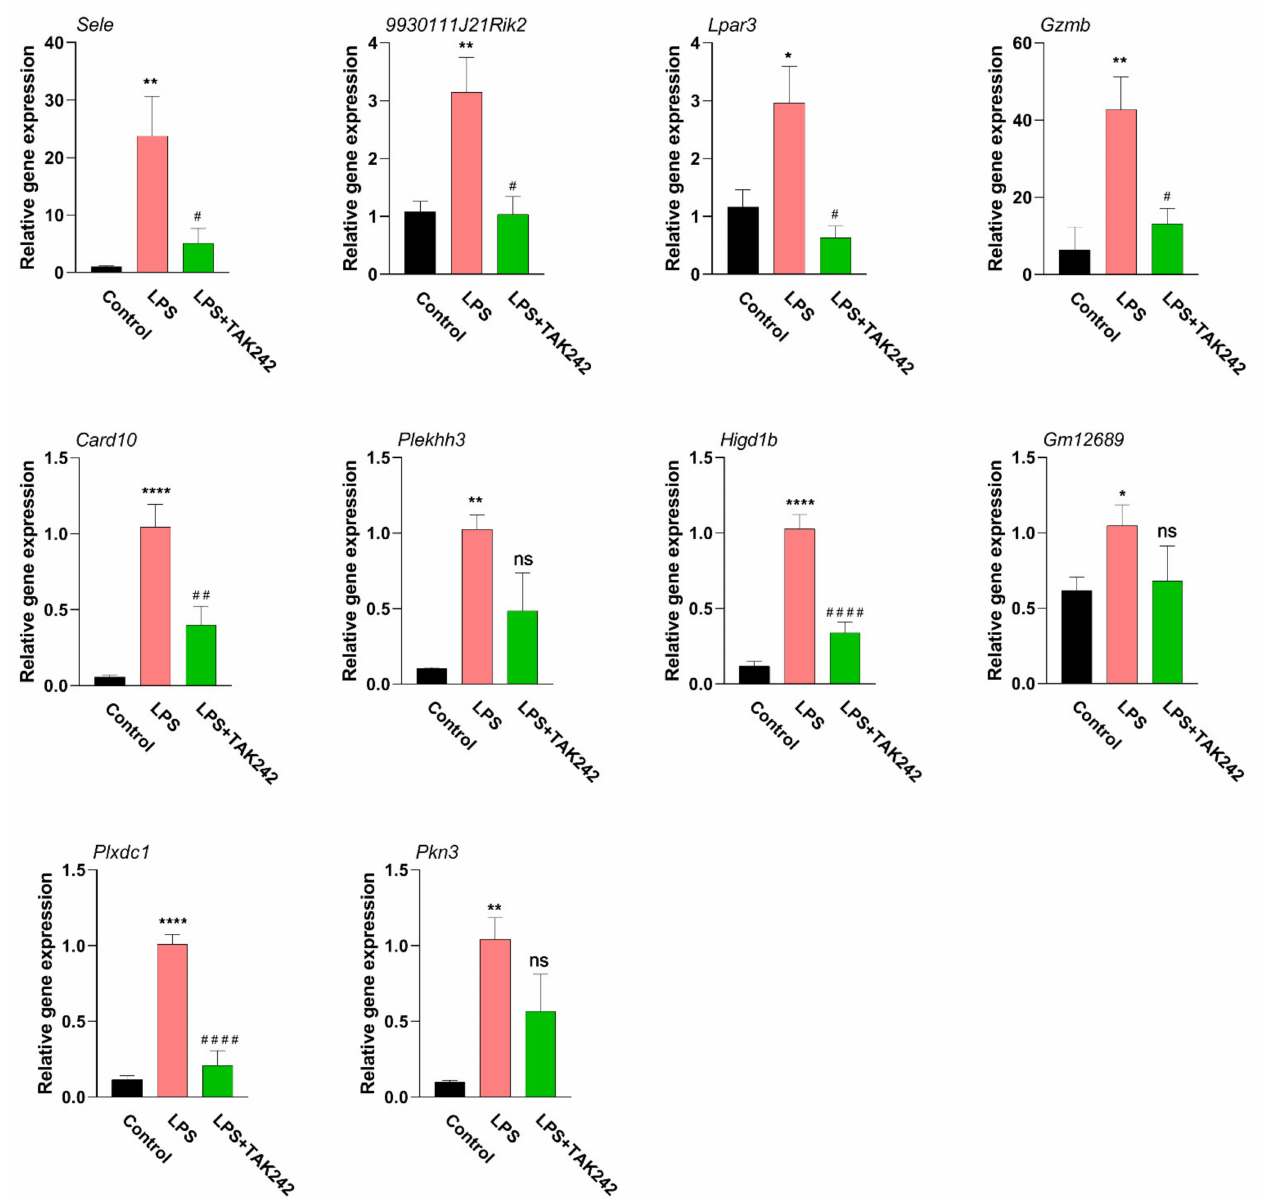
Figure 10. The verification of gene expression of hub genes by qPCR. Total RNA was isolated, followed by a qPCR examination. The gene expression was normalized by GAPDH ( n = 6). *, significantly different from the control group; * p < 0.05; ** p <0.01; **** p < 0.0001. #, significantly different from the LPS group; # p < 0.05; ## p < 0.01; #### p < 0.0001. The data were demonstrated as the means ± S.E.M. Statistical significance interpretation was carried out by using the one-way ANOVA followed by the Tukey post hoc